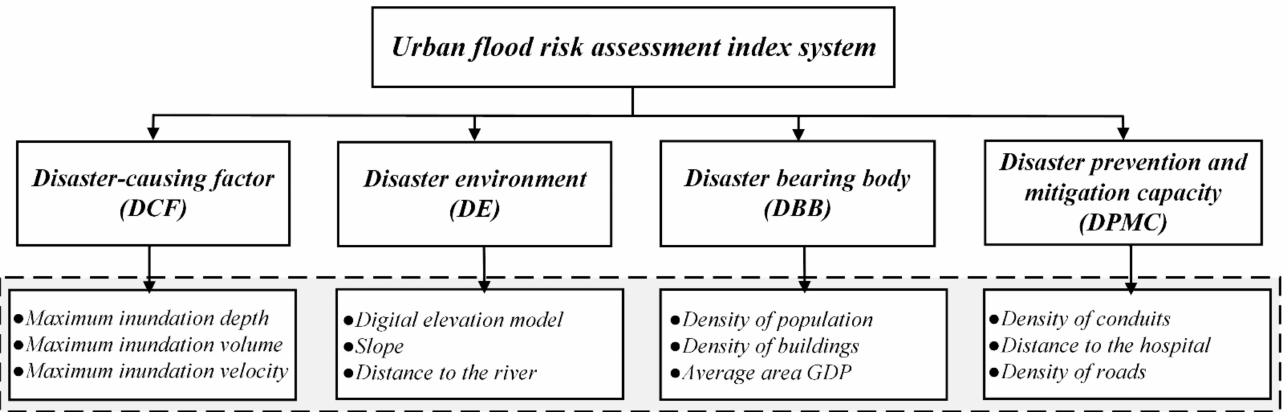
Figure 3. Risk index system of urban